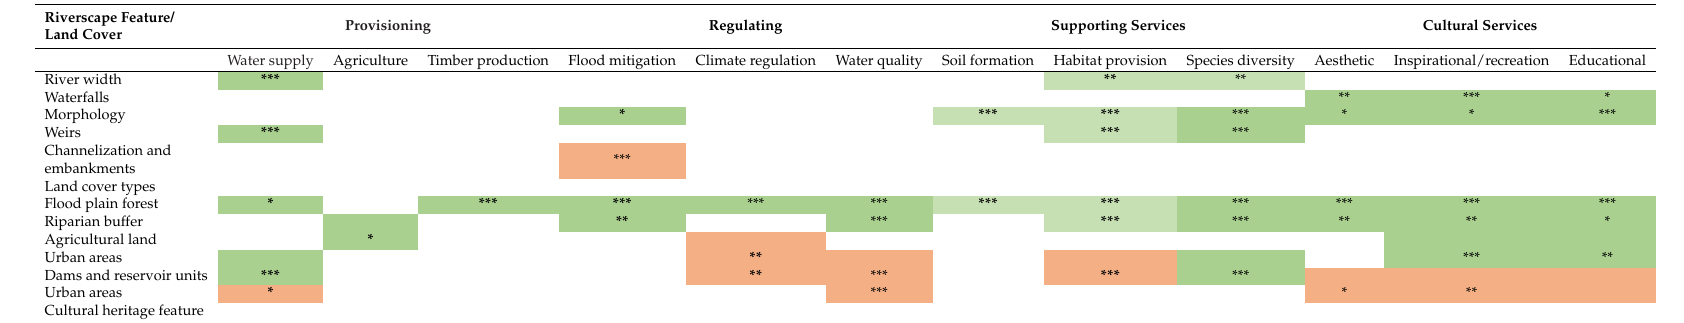
Table 3. The matrix linking ecosystem services with river landscape features. Source: adapted from Keele et al. [45].